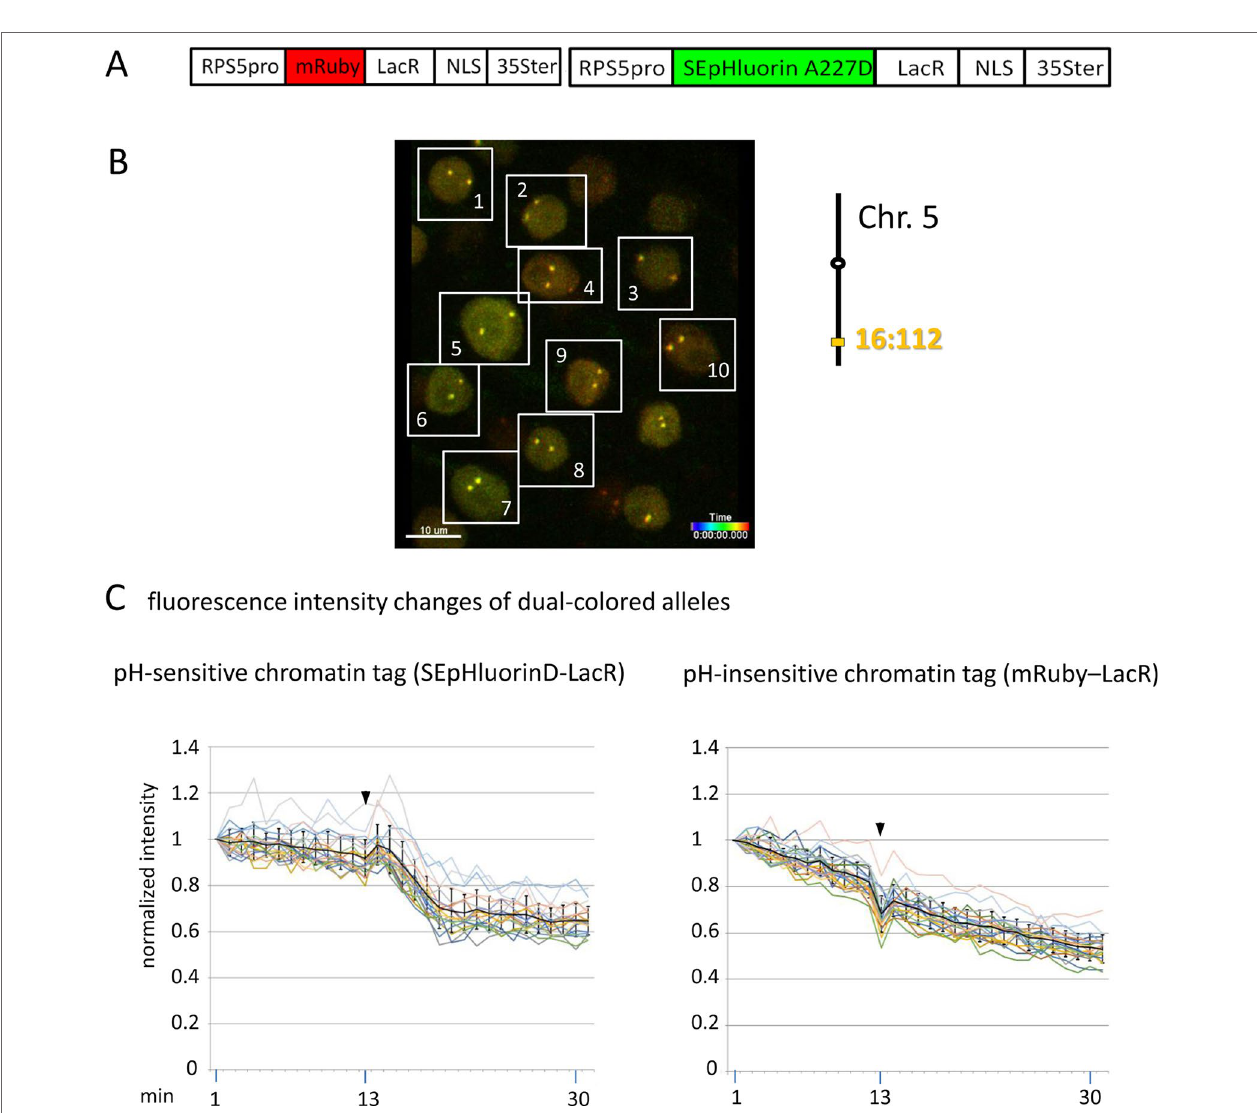
FIGURE 5 | Comparison of fluorescence intensity changes of pH-sensitive and pH-insensitive fluorescent DNA-binding proteins following addition of eATP. (A) The construct used in this experiment encoded a nuclear-localized SEpHluorinD-LacR fusion protein as a pH-sensitive fluorescent DNA-binding protein, and mRuby- LacR as a pH-insensitive DNA-binding protein. Both genes are under the transcriptional control of the RPS5 promoter and the 35ter ( Data Sheet 1 , combination Figure 5 , in supplement). Right: The SEpHluorinD-LacR fusion protein and the mRuby-LacR fusion protein both bind to the tandem lacO repeats integrated at locus 16:112 on the bottom arm of chromosome 5. (B) Confocal image (maximum projection; enlargement in Data Sheet 9 in supplement) of double fluorescent-tagged locus 16:112 at time point t1 in nuclei of cells in the root transition zone. Two yellow dots are visible in most nuclei. Nuclei used for fluorescence intensity analysis (part C ) are boxed in white. (C) Fluorescence intensity changes of dual-colored alleles. Response of pH-sensitive tag SEpHluorinD-LacR (left) and pH-insensitive mRuby-LacR (right) to eATP addition (black arrowheads, frames 13-14) . Fluorescence intensity profiles of normalized intensities of all 10 nuclei recorded in the green and red channels in the same experiment are overlaid in two separate graphs together with the calculated average values, to which standard deviation bars were added ( Table 10 , Data Sheet 6 , in supplement) . Normalized and non-normalized data can be viewed respectively, in Data Sheets 6 of Tables 10 and 1 . Using the normalized data, the calculated difference in the magnitude of the drop in fluorescence intensity of SEpHluorinD-LacR versus mRuby-LacR between the time points 14 to 21 in response to eATP is statistically significant ( p ≤ 0.05). The spike in fluorescence of the mRuby pH-insensitive tag reflects dislocation turbulence following eATP application. Fluorescence intensities of individual nuclei are shown in supplementary Data Sheet 8 , part Figure 5C . ΔpH values are shown under each nucleus1-10 for both alleles [maximum ΔpH 0.5 (nucleus 5, one allele); minimum ΔpH 0.2 (nuclei 1, 2, 4, 6,9, one allele, nucleus 10 both alleles); average ΔpH 0.3 (n = 20)]. Fluorescence intensity at genomic location is read in spot objects (1 – 2.8 μm) capturing punctual